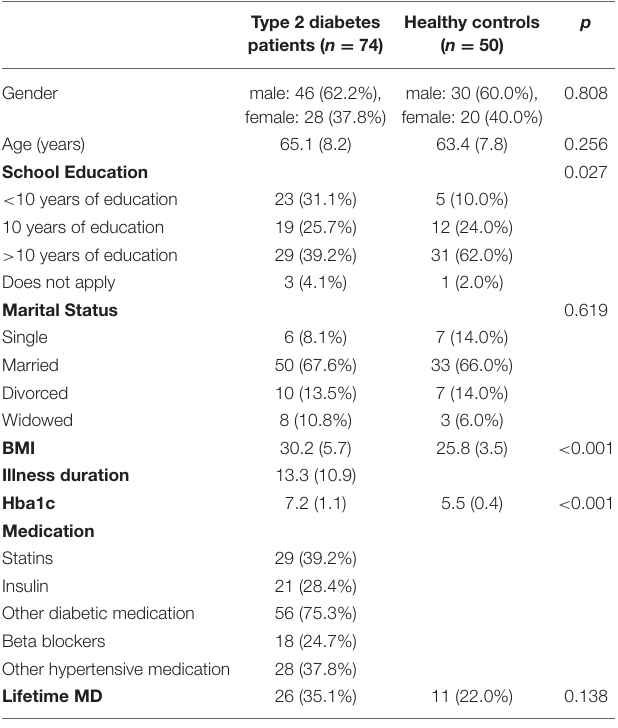
TABLE 1 | Sample description and differences between type 2 diabetes patients and healthy control participants.